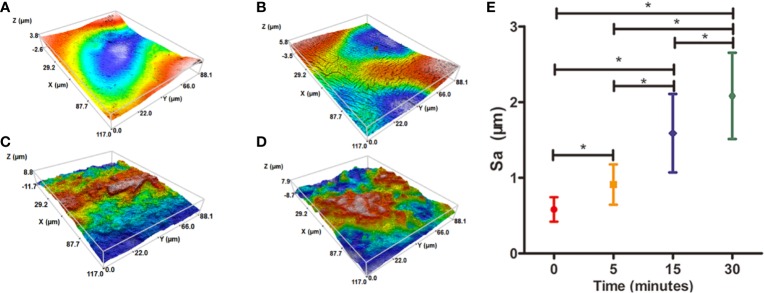
Three-dimensional (3D) confocal topographical images of poly(ε-caprolactone) (PCL) scaffolds' surfaces treated by 5 M NaOH at different time point. (A) 0, (B) 5, (C) 15, and (D) 30 min. The results of average roughness values (Sa) of PCL scaffolds' surfaces treated by 5 M NaOH at different time point, *P < 0.05 (E).